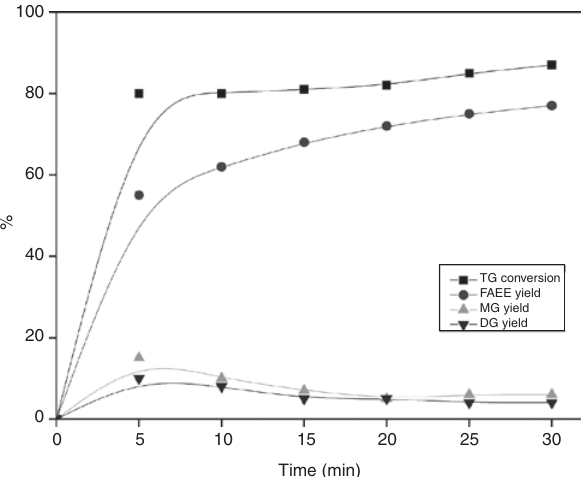
Figure 7: Effect of time at reaction conditions: temperature 340 ° C and ratio 42/1.